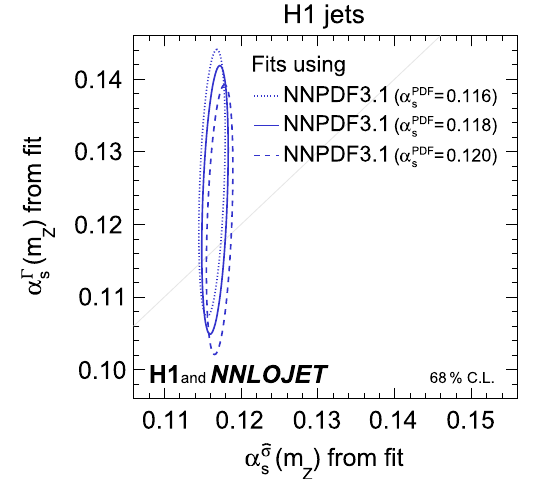
fitted values of α s ( m Z ) on the input PDFs for separate fits of inclusive jet and dijet data. Shown are fits using the ABMP, CT14, HERAPDF2.0, MMHT and NNPDF3.1 PDF sets. For each case, the PDFs are available for different input values α PDF s ( m Z ) used for the PDF determination, and these values are displayed on the horizontal axis. The PDFs are available only for discrete values of α PDF s ( m Z ) and the results are connected by smooth lines. The lower panel displays the resulting values of χ 2 / n dof of the